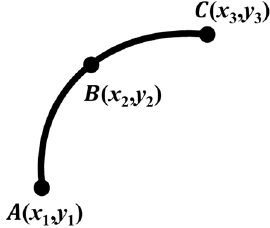
Figure 12. Three-point determination curve.